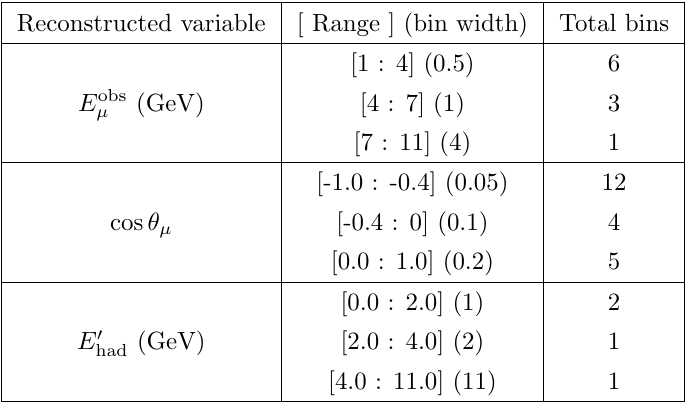
Table 3 . The binning scheme used in 2D ( E (cid:22) , cos (cid:18) (cid:22) ) and 3D ( E (cid:22) , cos (cid:18) (cid:22) , E 0